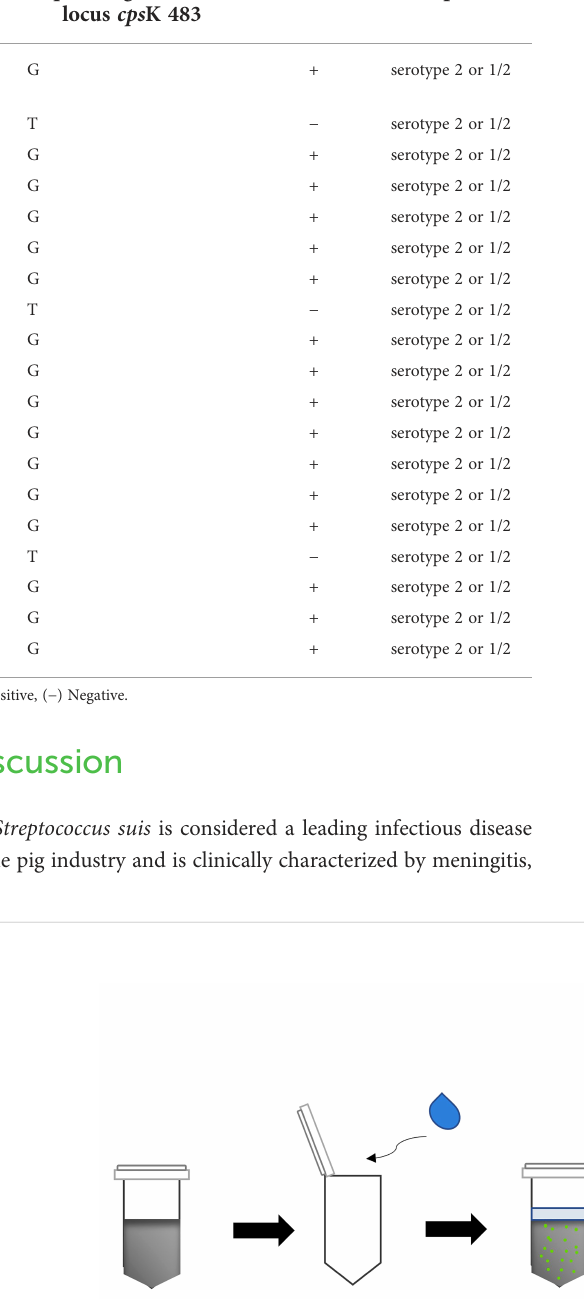
TABLE 3 The application of the LP-LAMP method in POCT of clinical Streptococcus suis strains. NO.